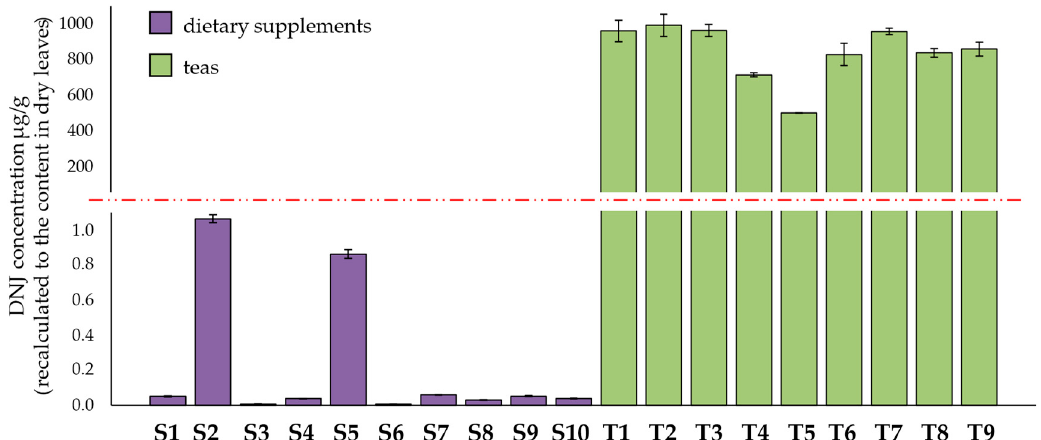
Figure 2. DNJ content in samples expressed in µg/g (recalculated to the content in dry leaves). The red dotted line indicates the gap on the scale (for DNJ concentration between 1.2-100 µg/g) . DNJ concentrations in dietary supplements (S1–S10) and leaves (T1–T9) (expressed